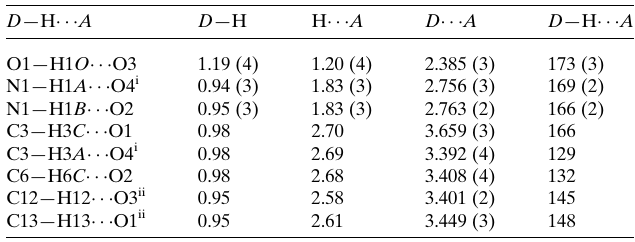
Table 2 Experimental details.